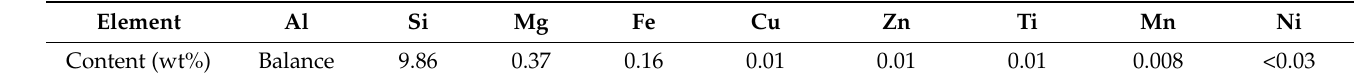
Table 1. Chemical composition of the AlSi10Mg alloy powder used in this